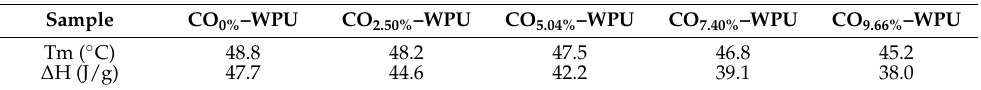
Figure 6. DSC thermograms of WPU films. Table 2. Thermal properties of WPU